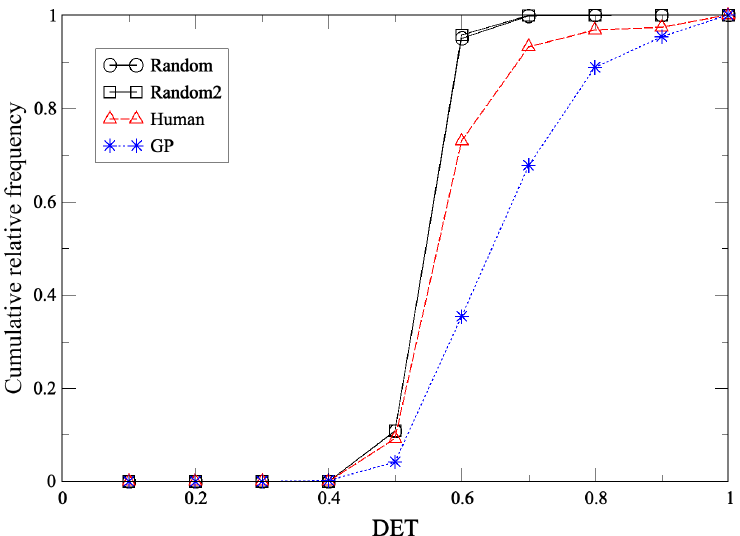
Figure 7. Cumulative relative frequency distribution of DET from recurrence plot obtained from the set of RPS time series. The RPS time series were generated by pseudorandom set, human, and the strategy inferred using GP. Here, “Random” and “Random2” show the results from the sets of 500 and 10 8 pseudorandom series generated using the Mersenne Twister,